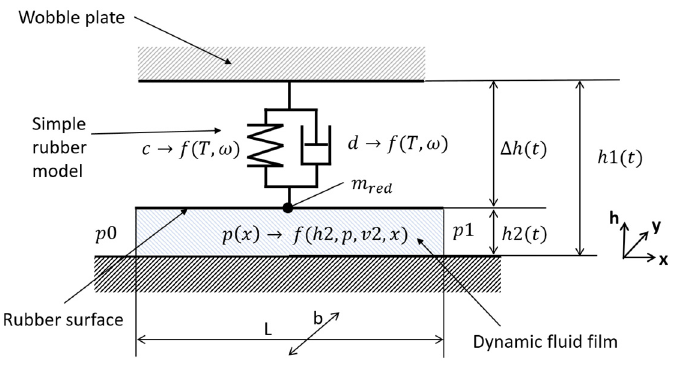
Figure 8. The simplified mechanical model of the emerging fluid gap caused by the rubber on the wobble plate.